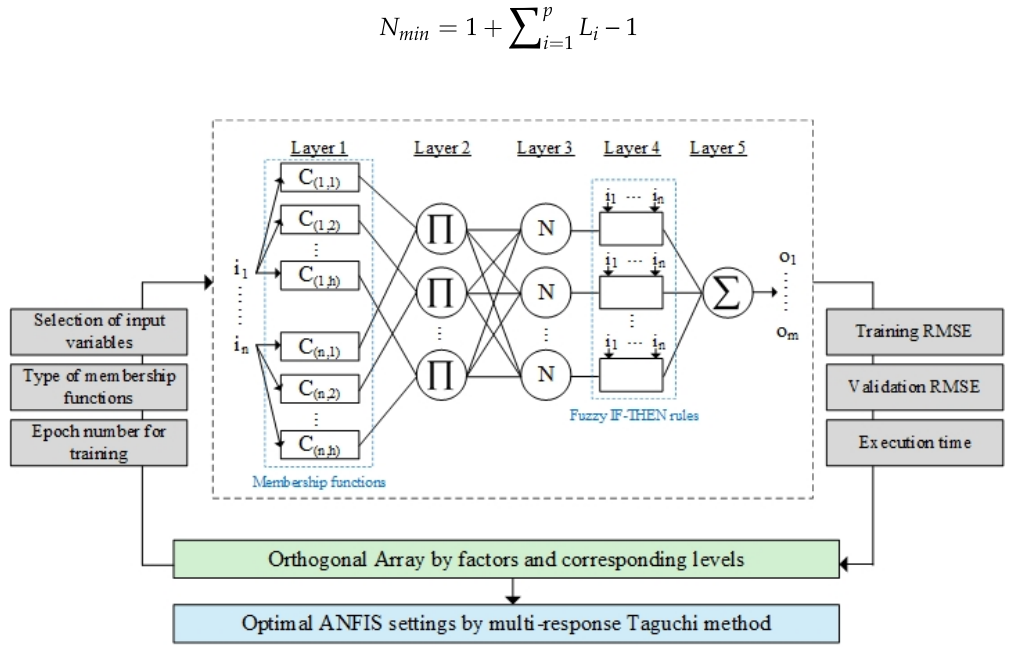
Figure 3. Architecture of the MRTM-guided ANFIS.